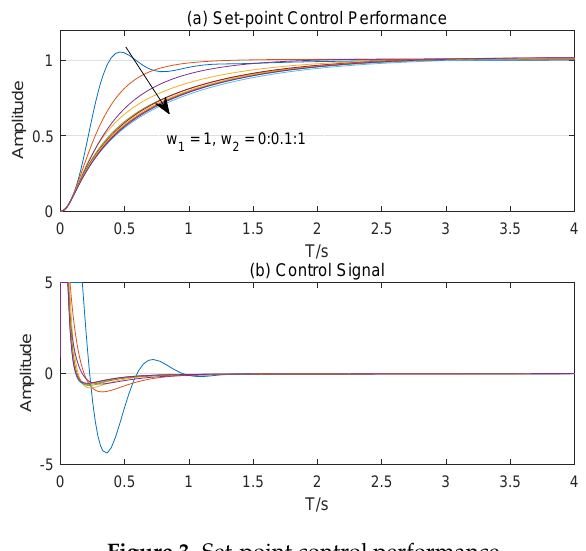
Figure 3. Set-point control performance.